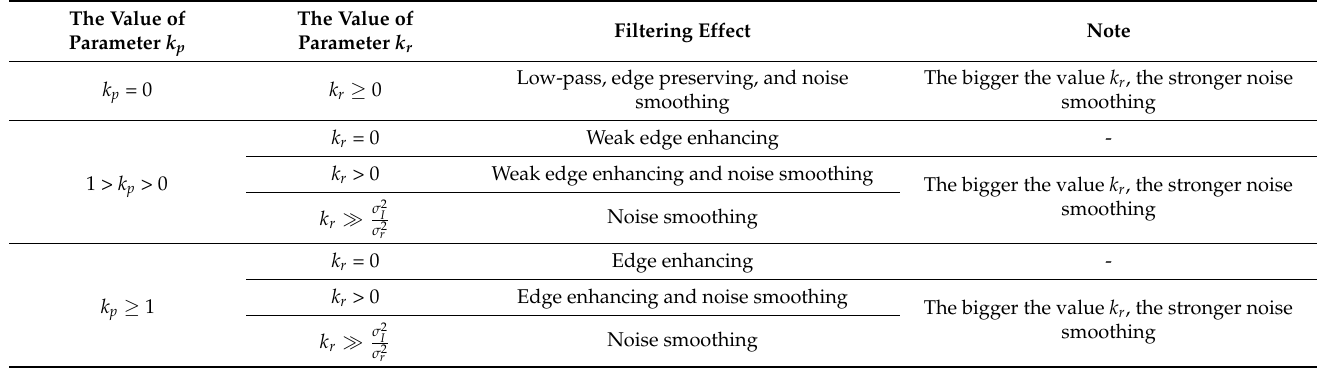
Table 6. Different filtering effects with different parameter